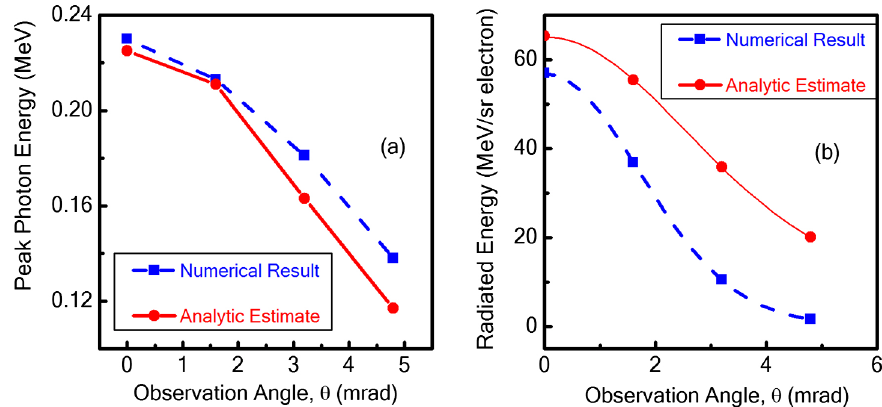
FIG. 4. Radiated peak spectral photon energy versus observation polar angle (a) calculated numerically (blue squares) and estimated analytically (red full circle). The radiated energy obtained numerically (solid blue square symbols) and estimated analytically with Eq. (3) (solid red full circle symbols) is shown in (b). The lines are to guide the eye. The photon flux obtained by integrating the curves in (a) is 0 : 015 photons = electron (analytic estimate) which is greater than 2 times 0 : 006 photons = electron obtained with our